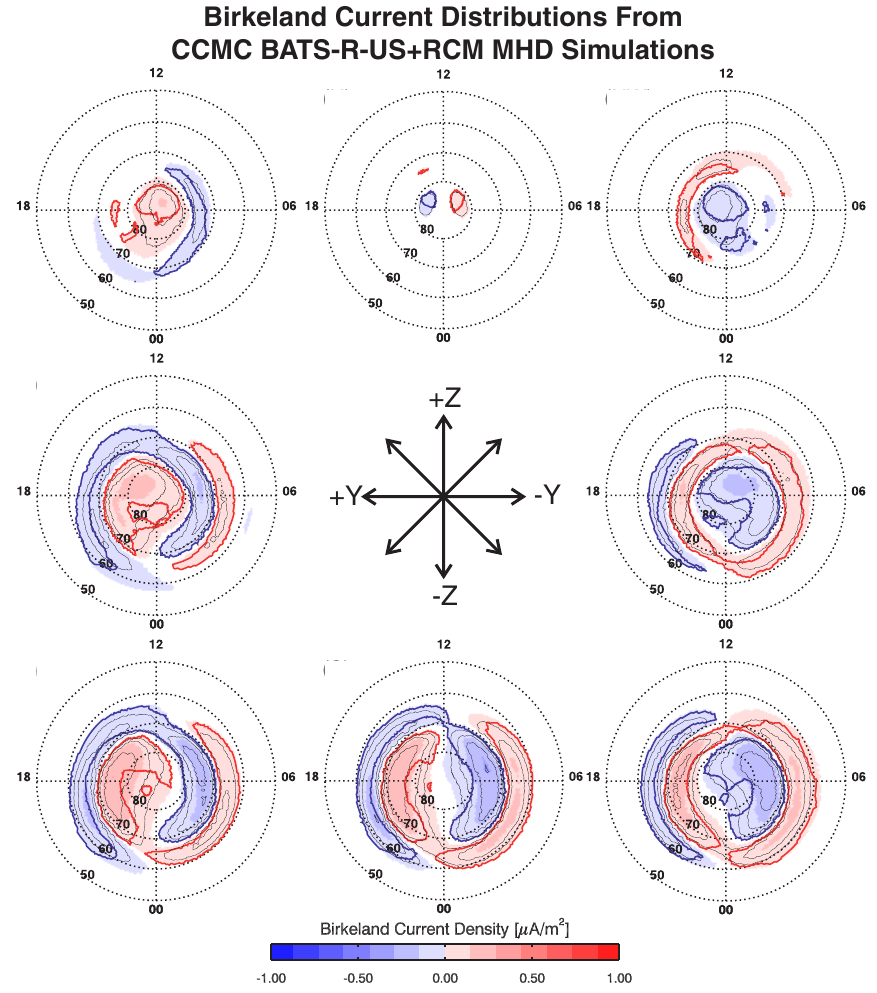
Fig. 4. Large-scale Birkeland current distributions from two-hour MHD simulations using the BATS-R-US plus RCM model running at the CCMC shown in the same format as Fig. 3. The red and blue contours indicate the overlap of the large-scale upward and downward current regions, respectively, with those obtained from the observations. Table 1. Dependence of the similarity of observed and simulated Birkeland current patterns on IMF clock angle. The similarity is quan- titatively defined by the average factional overlap of the large-scale current regions, Q OS , and the two-dimensional correlation coefficient computed without rotation or shift, r OS . Azimuth rotation and equatorward shift shown are the lags maximizing the correlation